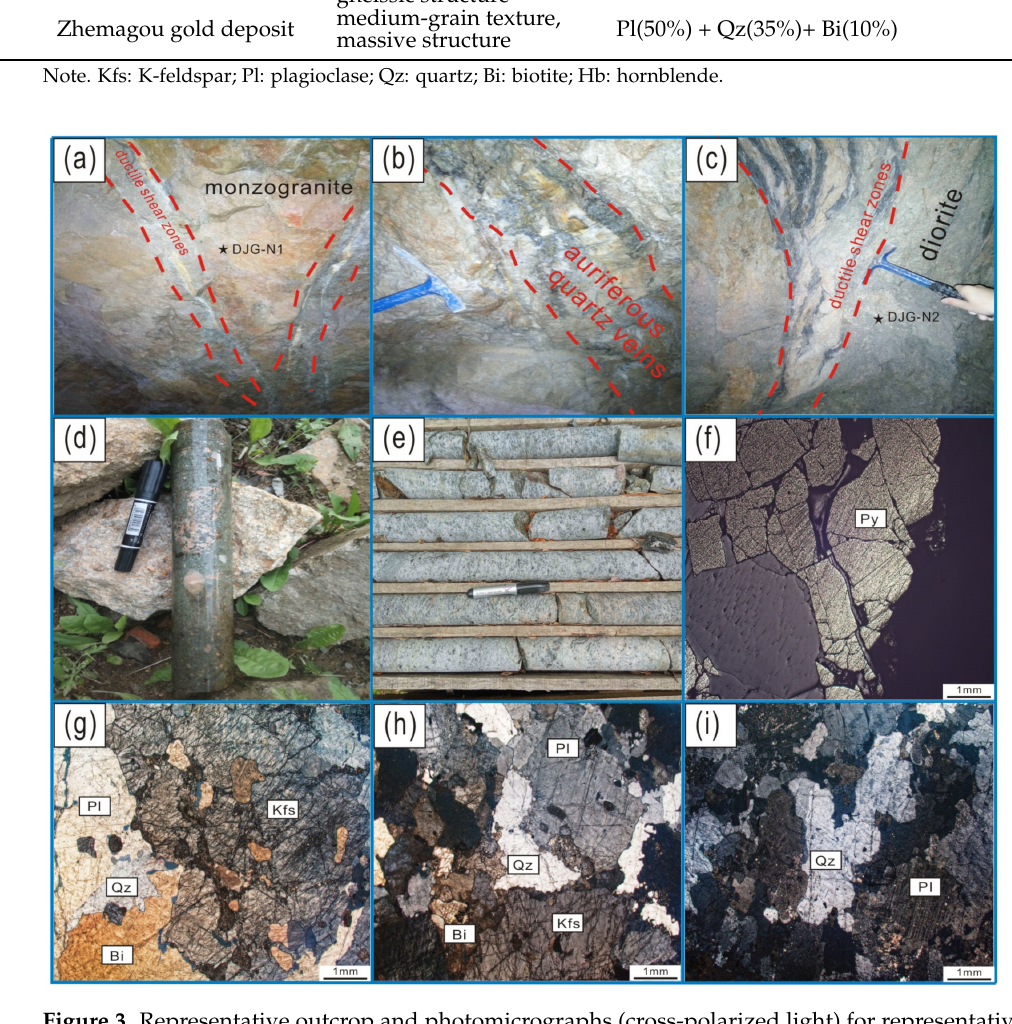
Figure 3. Representative outcrop and photomicrographs (cross-polarized light) for representative igneous rocks in the Liuhe gold Orefield, NE China: ( a ) spatial relationship between monzogranite and ductile shear zones; ( b ) auriferous quartz veins in the ductile shear zones; ( c ) spatial relationship between ductile shear zones and altered fine-grained diorite; ( d ) monzogranitic breccia (BHG-N1); ( e ) trondhjemite (ZMG-N1); ( f ) pyrite in diorite (DJG-N2); ( g ) photomicrograph of monzogranite (GLG-N1); ( h ) photomicrograph of monzogranitic breccia (BHG-N1); ( i ) photomicrograph of trond- hjemite (ZMG-N1). Pl: plagioclase; Kfs: Kfeldspar; Qz: quartz; Bi: biotite; Ser: Sericite Py: